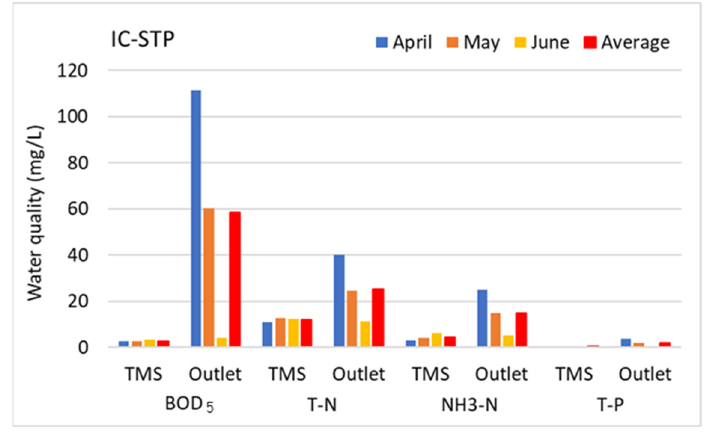
Figure 7. Comparison of water quality in the TMS and the discharge point of the IC-STP.